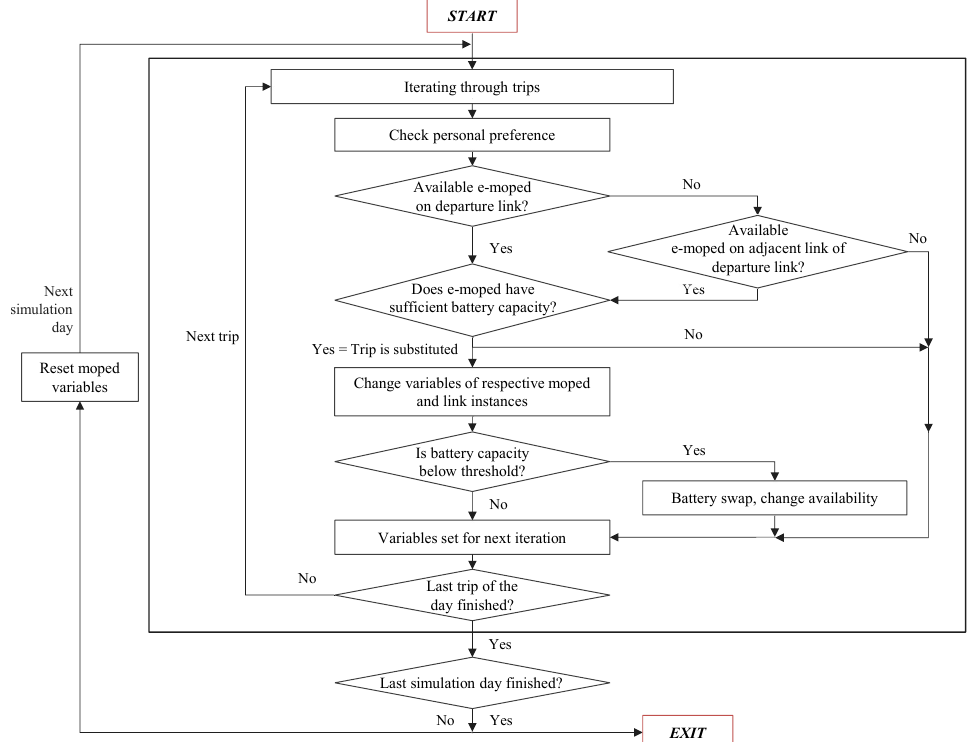
Figure 2. Decision model of sharing